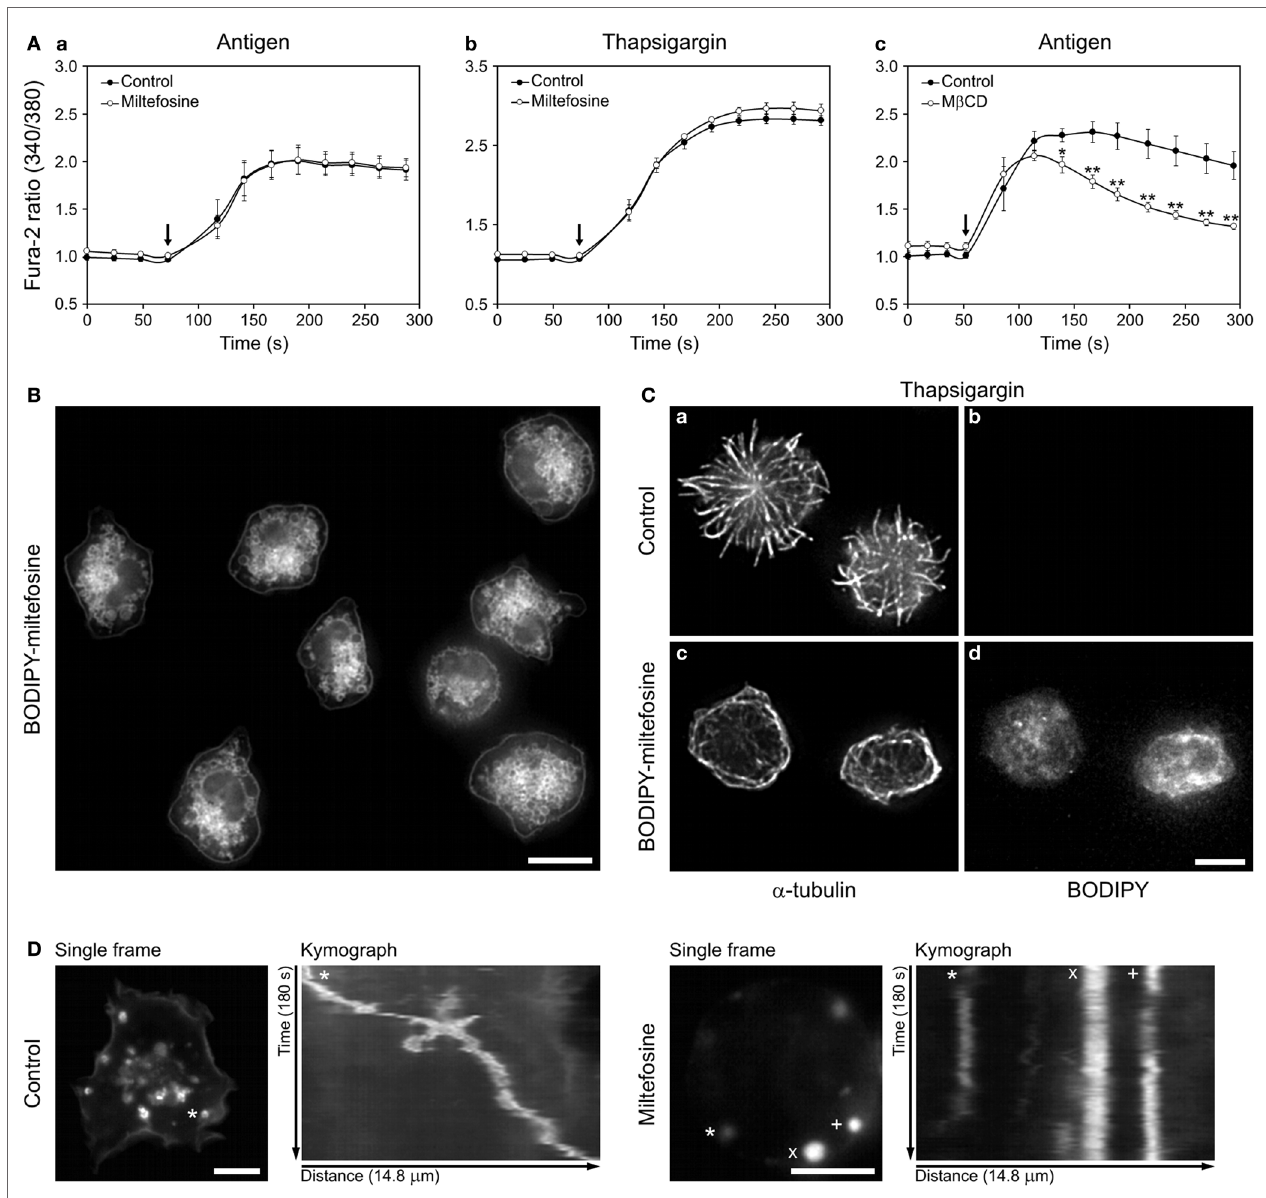
FigUre 4 | Miltefosine does not inhibit Ca 2 + influx in activated bone marrow-derived mast cells (BMMCs), but localizes to cellular membranes and inhibits the granule movement. (a) Effect of miltefosine (a,b) and methyl- β -cyclodextrin (M β CD) (c) on intracellular Ca 2 + level during cell activation. Sensitized cells were loaded with Fura-2-acetoxymethyl ester and pre-treated with or without (Control) miltefosine or M β CD. IgE-sensitized cells were activated by high affinity IgE receptor aggregation with Ag (a,c) or with thapsigargin (b). Arrows indicate addition of Ag or thapsigargin. Data represent mean ± SE [ n = 3 for (a,b); n = 4 for (c)] from independent experiments performed in duplicates; * p < 0.05 and ** p < 0.01. (B) BODIPY-miltefosine localizes to the cellular membranes and cytosol. Live-cell imaging of cells incubated with BODIPY-miltefosine. Scale bar, 10 µm. (c) BODIPY-miltefosine inhibits microtubule reorganization in activated cells. BMMCs treated or untreated (control) with BODIPY-miltefosine were activated by thapsigargin, fixed and stained for α -tubulin (a,c). Staining of BODIPY (b,d). Images (b,d) were collected and processed under identical conditions. Scale bar, 5 µm (a–d). (D) Time-lapse imaging of wheat germ agglutinin-stained intracellular granules in control and miltefosine-treated BMMCs. First frames from 180s time-lapse imaging and kymographs of stained granules are shown. The same track length (14.8 µm) was used for analysis in both cases. The tracked granules are marked by asterisks, cross, and diagonal